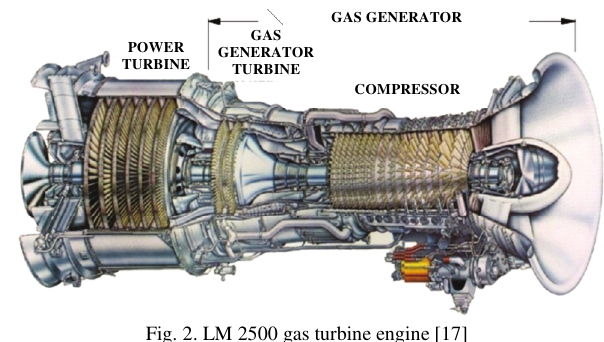
Fig. 2. LM 2500 gas turbine engine [17]